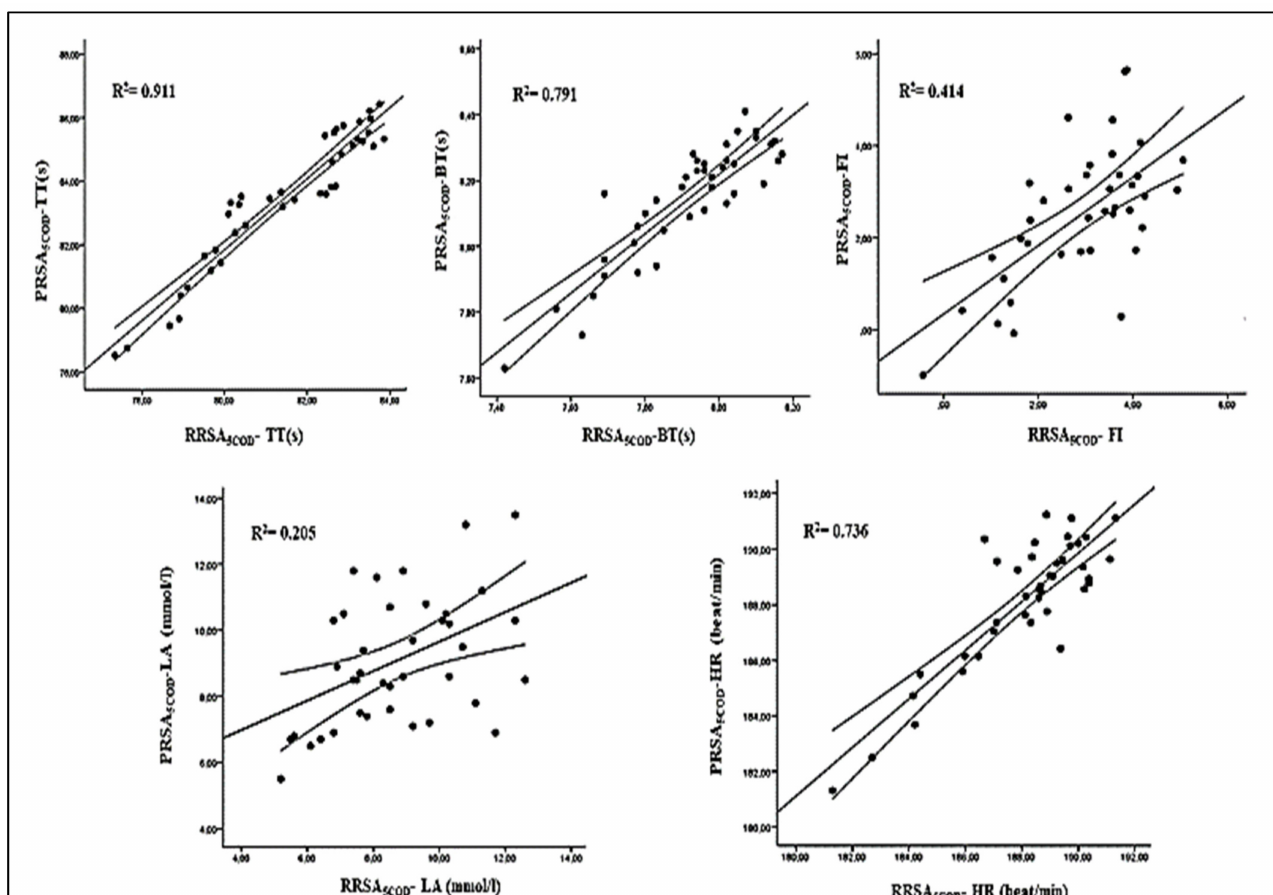
Figure 3. Correlation between RRSA 5COD and PRSA 5COD tests for professional and semi-professional group for each parameter. Legend: TT: total time; BT: best time; FI: fatigue index; HR: heart rate; LA: Lactate concentration. For each graph is reported the regression line and the 95% confidence